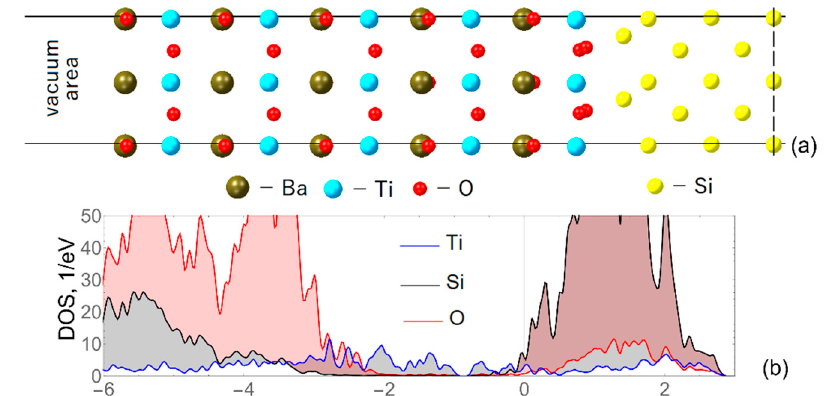
Figure 2. ( a ) The left half of the BaTiO 3 /Si unit supercell obtained after structure optimization. Barium atoms are brown spheres, titanium are blue, oxygen are red, and silicon are yellow. A vacuum area of about 20 Å is also presented, but was not shown in full size. The dashed lane denotes the middle of the supercell. ( b ) The corresponding density of the states spectrum, where the red region is assigned to oxygen atoms, the blue one to silicon atoms, and the black one to titanium atoms. Zero on the energy scale represents the Fermi level. The band gap is completely closed.